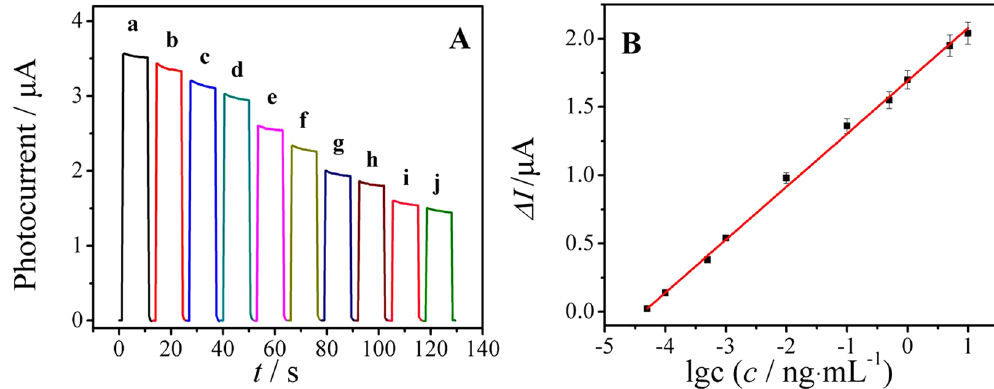
Figure 5. ( A ) Photocurrent responses of the PEC immunosensor with different concentrations of PSA: (a to j) 0.05, 0.1, 0.5, 1, 10, 100, 500, 1000, 5000, 10000 pg·mL − 1 . ( B ) The logarithmic calibration curve for PEC immunosensor for the detection of different concentrations of PSA.